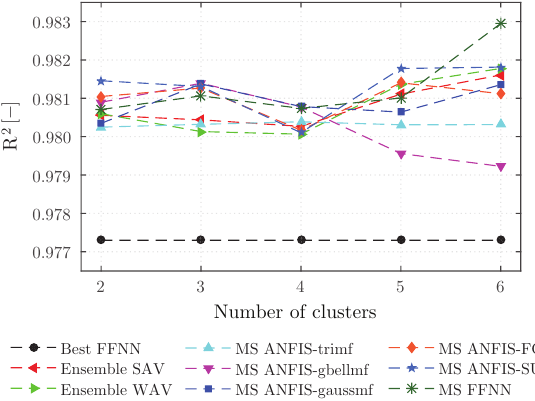
Figure 12: MAPE for different cluster number for